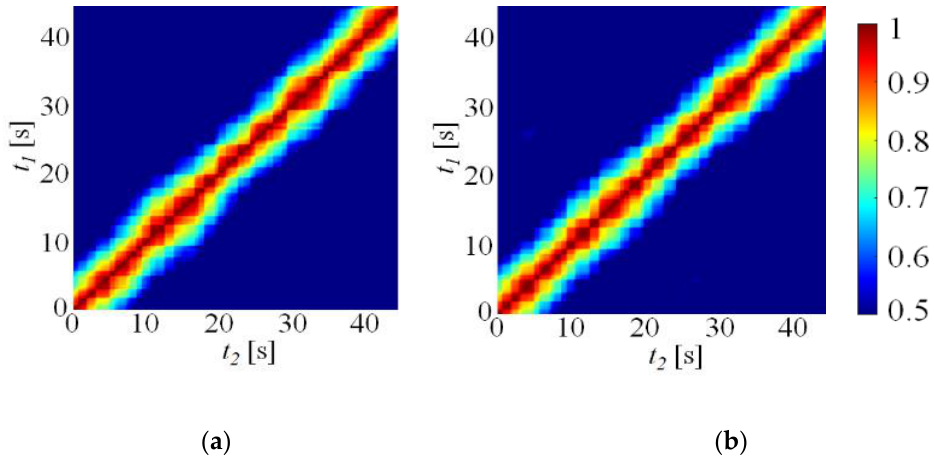
Figure 7. Cross-correlations of heat fluxes at two positions of Ch7 at Q ele = 3.5 W, ( a ) 7a and 7d, ( b ) 7c and 7d.